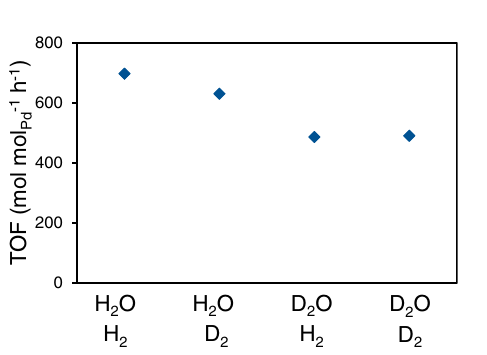
Fig. 3 | Turnover rates of benzyl alcohol hydrogenolysis in H 2 O-H 2 , H 2 O-D 2 , D 2 O-H 2 ,andD 2 O-D 2 . Reactioncondition:at298Kandatmosphericpressurewitha benzyl alcohol concentration of 20mM on Pd/C and 0.2M phosphoric acid.